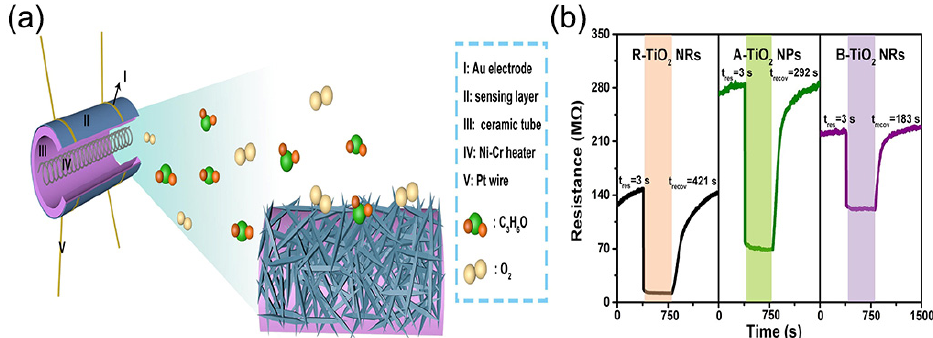
Figure 5. ( a ) Schematic diagram of sensor structure based on R-TiO 2 NRs sample. ( b ) Single-cycle resistance transient curves of three nanoparticles to 100 ppm acetone at 320 °C. Reproduced with permission from Ref. [41]; published by Academic Press Inc., 2022.